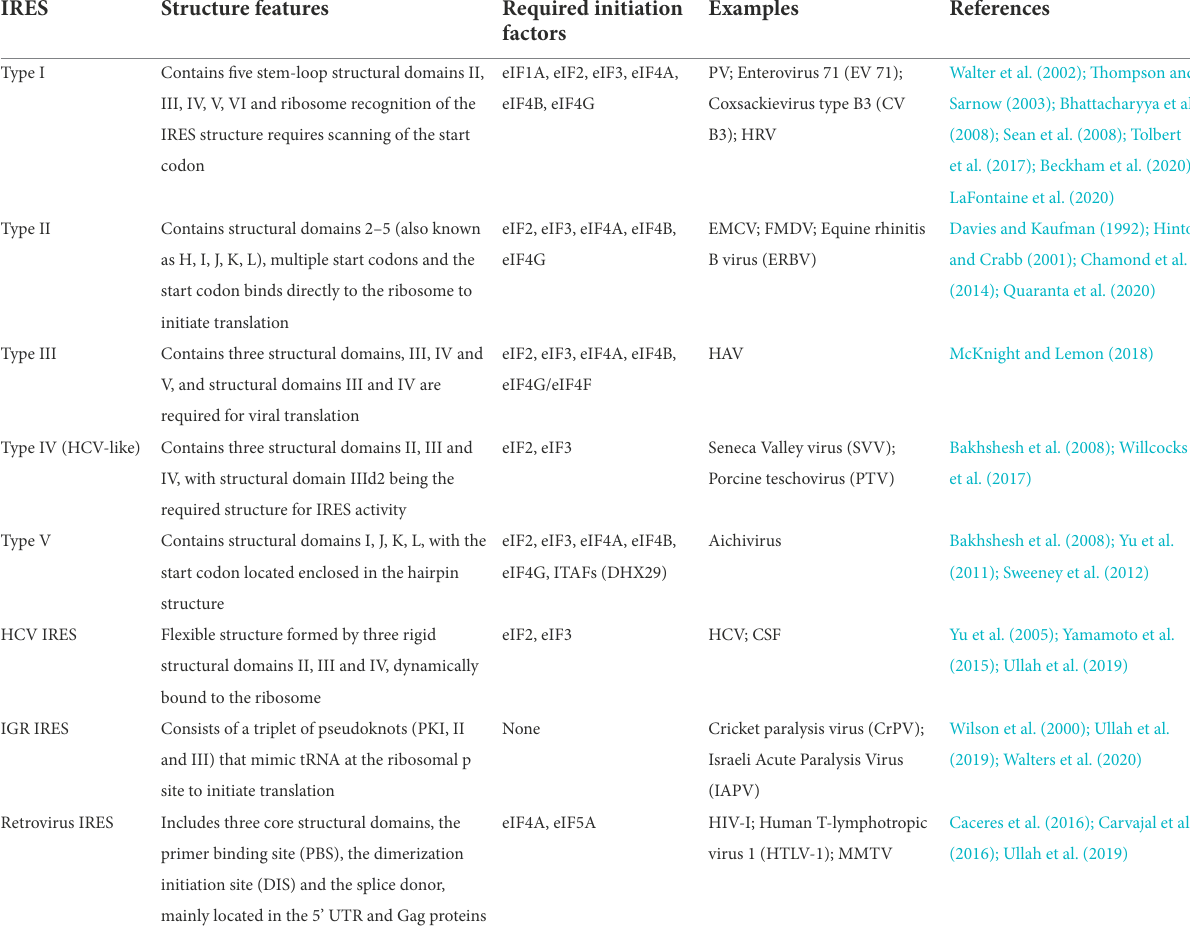
TABLE 1 Characteristics and classification of IRES of RNA